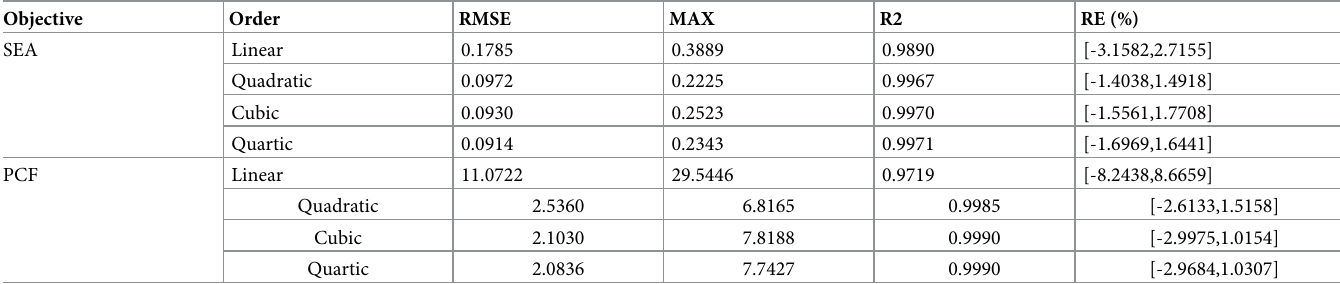
Table 4. Accuracies of the different polynomial functions for the tubes.